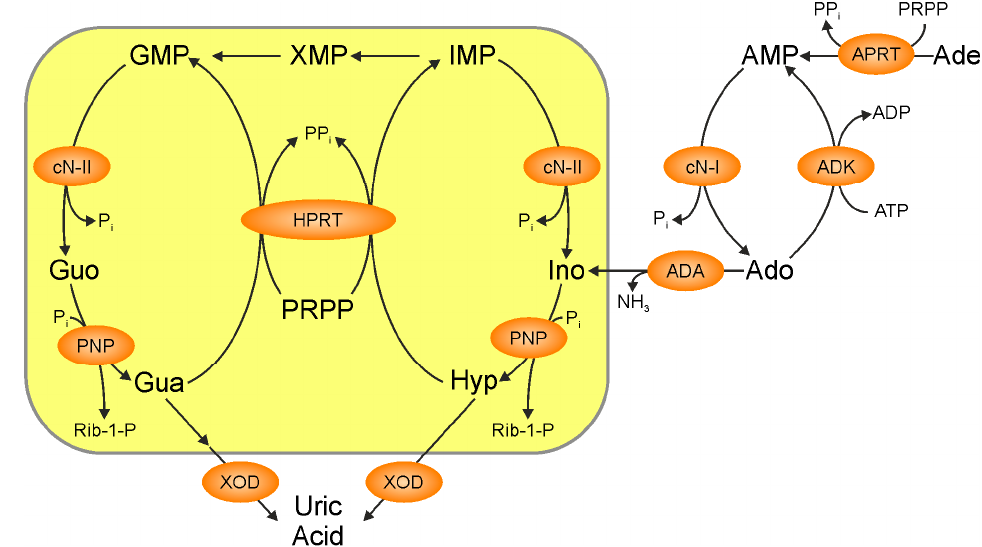
Figure 2. Purine salvage and catabolism. APRT: adenine phoshoribosyltransferase, ADK: adenosine kinase, ADA: adenosine deaminase, cN-I: cytosolic 5 ′ -nucleotidase I, cN-II: cytosolic 5 ′ -nucleotidase II, HPRT: hypoxanthine-guanine phosphoribosyltransferase, PNP: purine nucleoside phosphorylase, XOD: xanthine oxidase, Ade: adenine, Ado: adenosine, Gua: guanine, Guo: guanosine, Hyp: hypoxanthine, Ino: Inosine, PRPP: 5-phosphoribosyl-1-pyrophosphate, Rib-1-P: ribose-1-phosphate. The yellow box: the purine cycle.